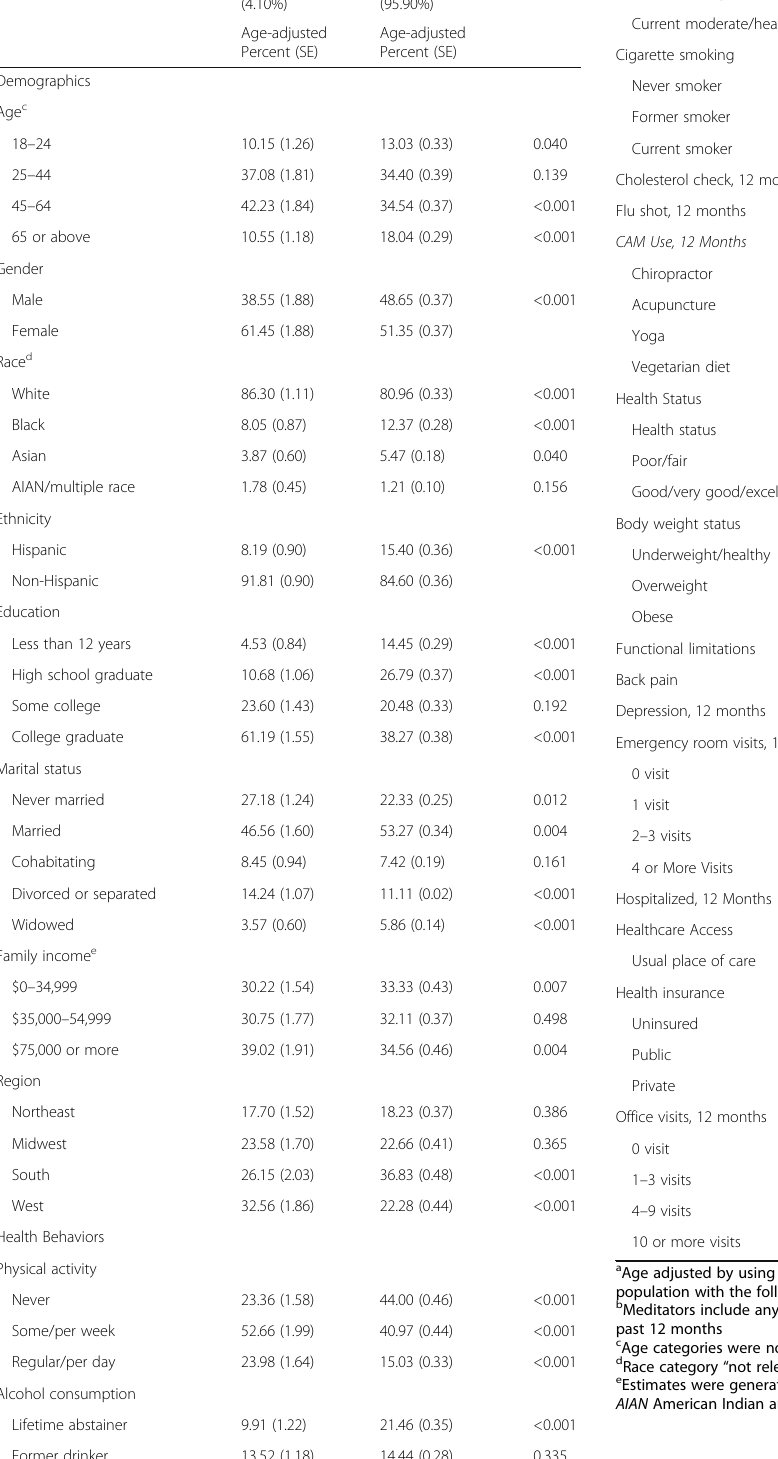
Table 1 Comparison of meditators and non-meditators by select user characteristics, use during the previous 12 months